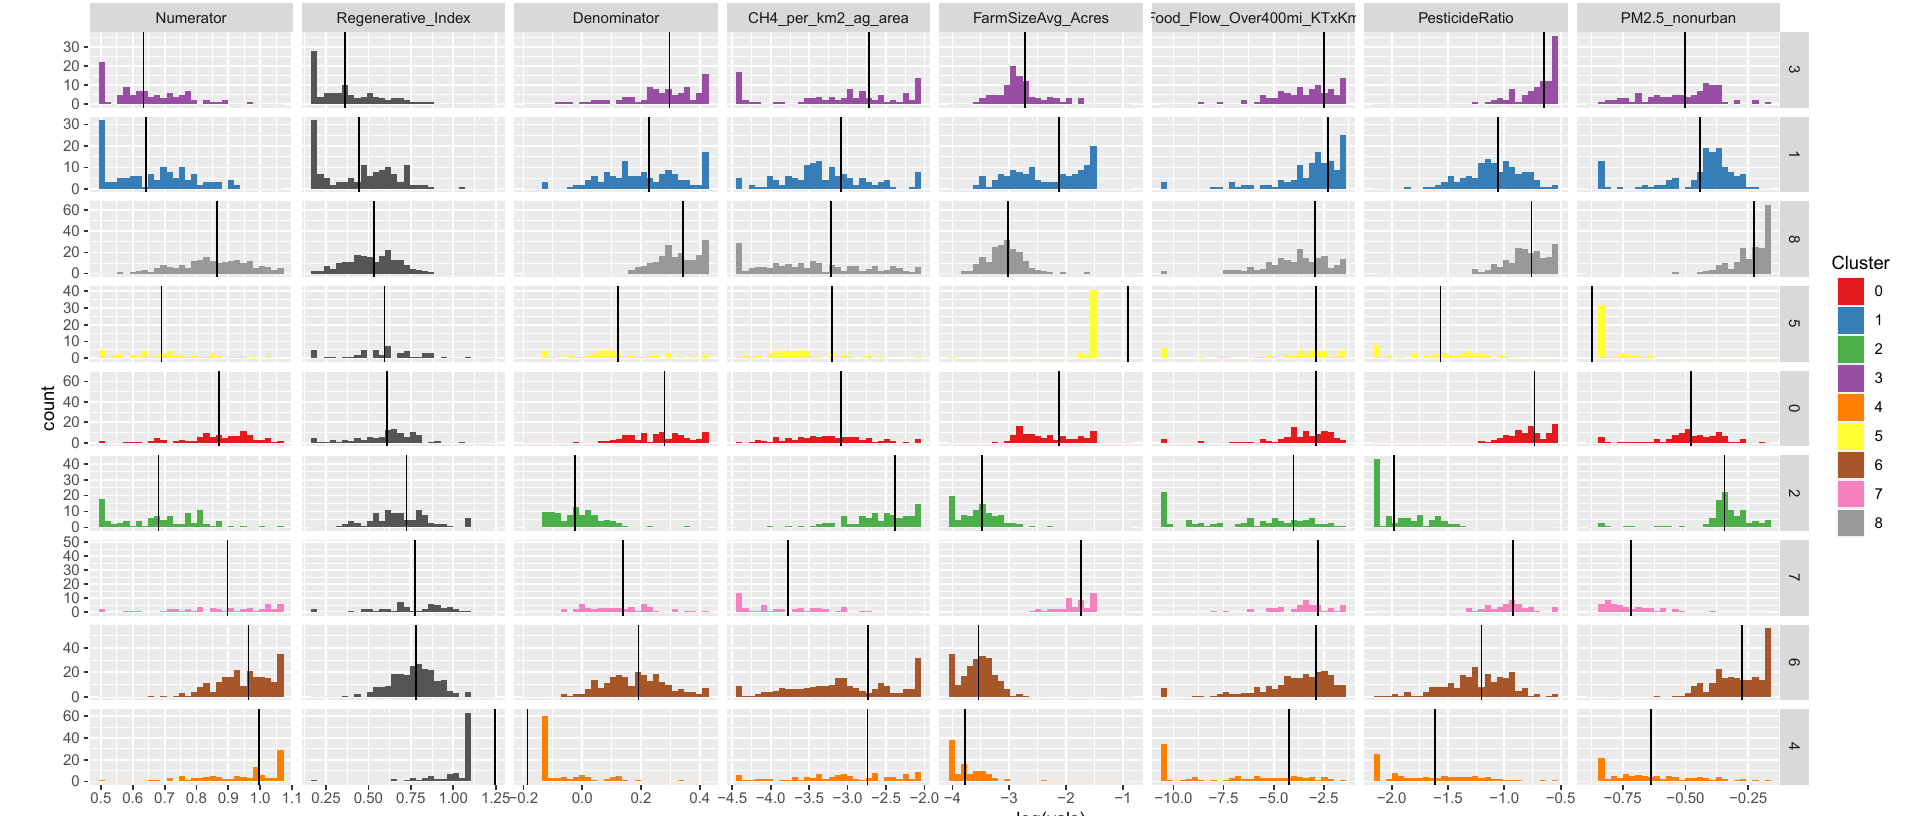
Figure 5. Histograms of index denominator variables broken out by county cluster membership. Each cluster’s counties have a row; each variable has a column. Although clusters are not calculated on the overall index, nor on the numerator or denominator, those three derived variables are presented here for reference in the leftmost three columns. Indeed, cluster rows are sorted by their overall regenerative index. A vertical black line indicates the mean value for the variables in its cluster. Note that, for efficient use of space on the visualization, the 7% highest and 7% lowest values for a given variable (regardless of which cluster they may be contained in) are not shown at their correct x -values; they are instead stacked in the histogram in the bins where the 7th and 93rd percentiles would be displayed, respectively. Vertical lines for mean values, however, are not constrained in this way but appear at their proper values, which on occasion leads to some of them seeming to appear outside of the